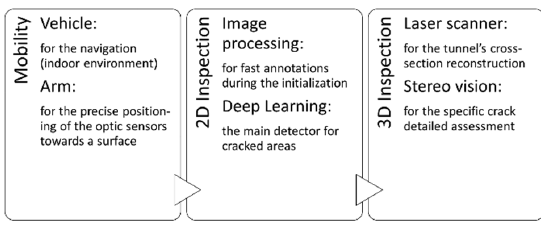
Figure 1. The robotic platform task description.